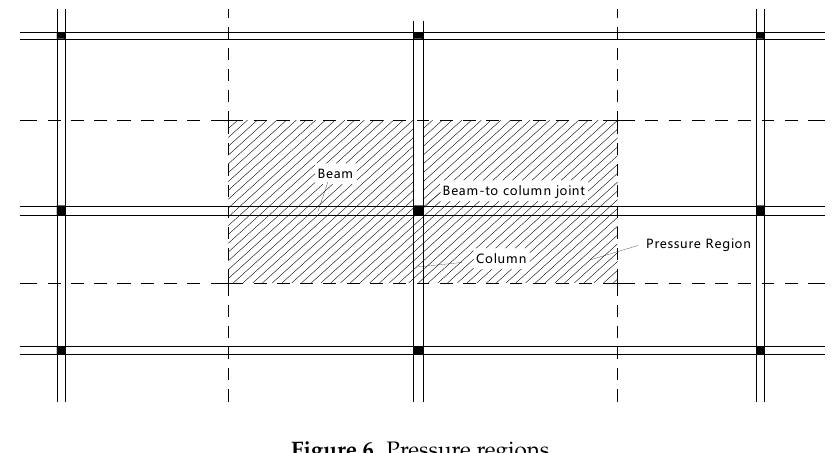
Figure 6. Pressure regions.